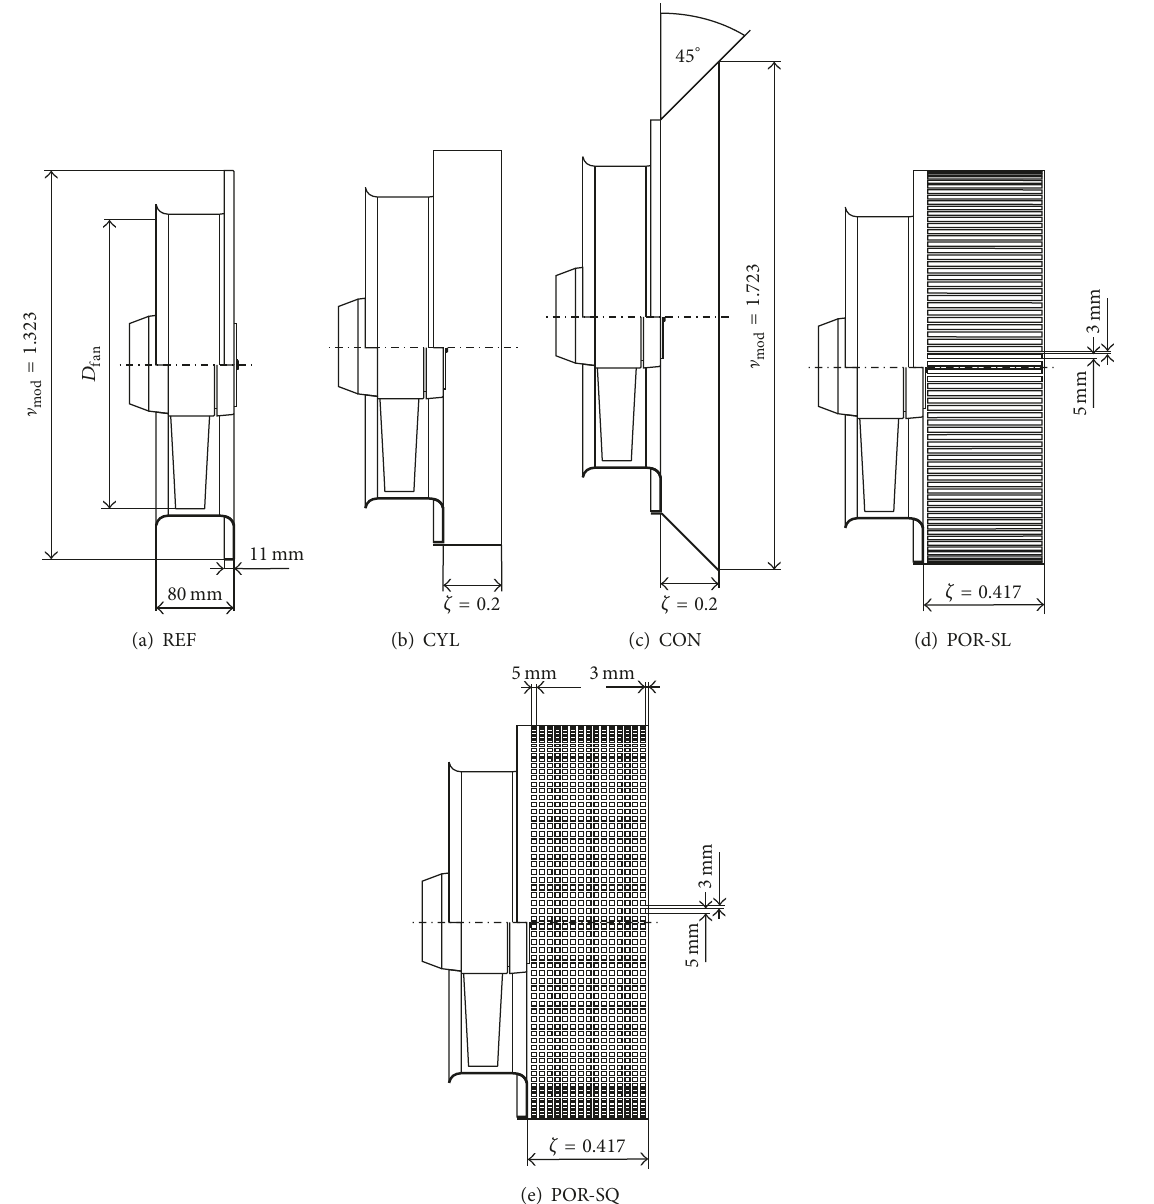
Figure 13: Basic geometries of inlet shroud